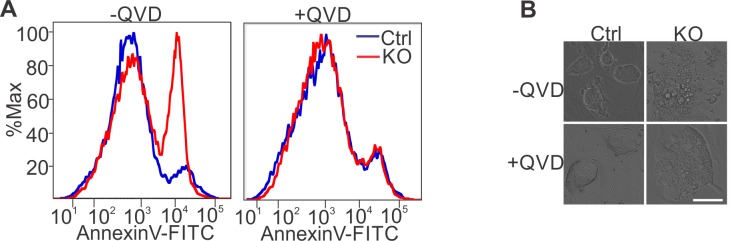
Apoptosis inhibition in SRSF3 depleted iPSCs.(A) Histogram of a representative experiments of data presented in Figure 2F. (B) Phase contrast images of untreated and QVD treated Srsf3-KO and control iPSCs 48 hr after 4OHT induction. Scale bar: 50 μm.